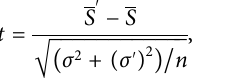
Frontiers in Earth Science |